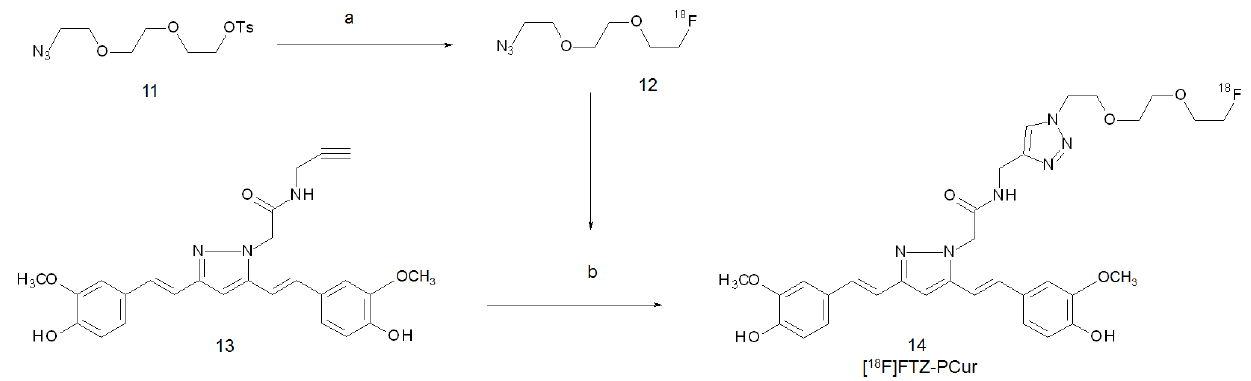
Figure 2. Reagents and conditions: ( a ) K 2 CO 3 , Kry2.2.2., [ 18 F]F - , DMSO, 100 °C, 5 min; ( b ) CuSO 4 (aq), sodium ascorbate (aq), DMSO, RT, 15 min.